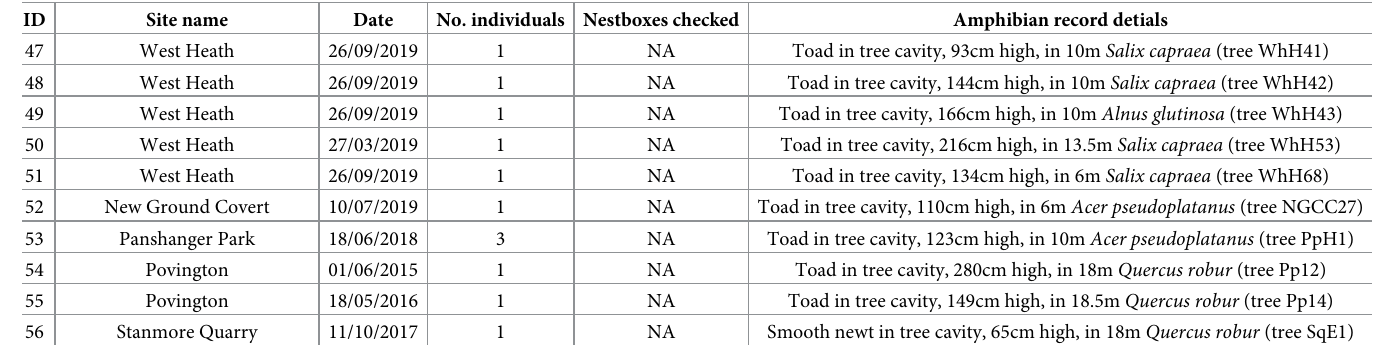
the mean height of cavities occupied by toads was 134 cm but there were records of 192 cm and 216 cm and the maximum recorded cavity height occupied by a toad was over 3 m, within a cavity with the entrance at 280 cm height in an oak tree and an additional 25 cm up above the entrance inside the feature (Fig 2A). The average size of trees occupied by amphibians in BTHK (trees used by toads: average height 10.4 m, average DBH: 28.8 cm) was smaller compared with the wider dataset of sur- veyed trees (average tree height: 12.6 m, average DBH: 43.6 cm), with wide variation between groups of animals recorded in tree cavities (Fig 3). In the BTHK dataset, the number of toad records was small, which limited the statistical power of our models to detect differences in tree measurements between trees with toads ver- sus other animals. The fixed effect of toad presence was poor at explaining the variation in dif- ferent tree and PRF measurements (extremely low marginal R 2 values, all less than 0.004) and it was clear that the random effects of survey location and tree identifier explained far more of the variation (higher values of conditional R 2 values ranging from 0.30–0.88). Nevertheless, summary statistics and high variability in tree and PRF measurements in the BTHK dataset supported our model’s inconclusive findings that toad selection of trees appeared similar com- pared to the wider dataset in terms of tree height (tstat: 0.71; pvalue: 0.98), DBH (tstat: 0.73; pvalue: 0.97), PRF entrance height (tstat: 0.97; pvalue: 0.93). Trees occupied by toads were also similar in height to those selected by blue tits, snails, slugs, and woodlice, where data were far more abundant (Fig 3; S1 Table), but there was an indication that snails were selecting lower height trees compared to the available trees (tstat: -2.86; pvalue: 0.04). There was no apparent pattern in the orientation of the entrances into PRFs used by amphibians, with three PRFs fac- ing NW, three SE, three SW, four West, four East and one North. Amphibians in BTHK were recorded in PRFs located in seven tree species: sycamore Acer pseudoplatanus , alder Alnus glutinosa , downy birch Betula pubescens , silver birch Betula pen- dula , hazel Corylus avellana , common oak Quercus robur and especially goat willow Salix caprea . Compared to the nearly 50 tree and shrub species surveyed overall in BTHK (including some hybrids and others identified only to genus level), the tree selection by amphibians was broadly similar to its availability in the dataset for some tree species, with the two most com- mon tree species surveyed in BTHK, sycamore and common oak (representing 6.9% and 11% of all trees surveyed), used by 17.6% and 11.8% of toads. However, there was a substantial dif- ference apparent for goat willow, which was used by 35.3% of amphibian records despite rep- resenting only 1.1% of all trees surveyed in the BTHK project and suggesting positive selection for the environmental conditions associated with this tree species (e.g. damp or